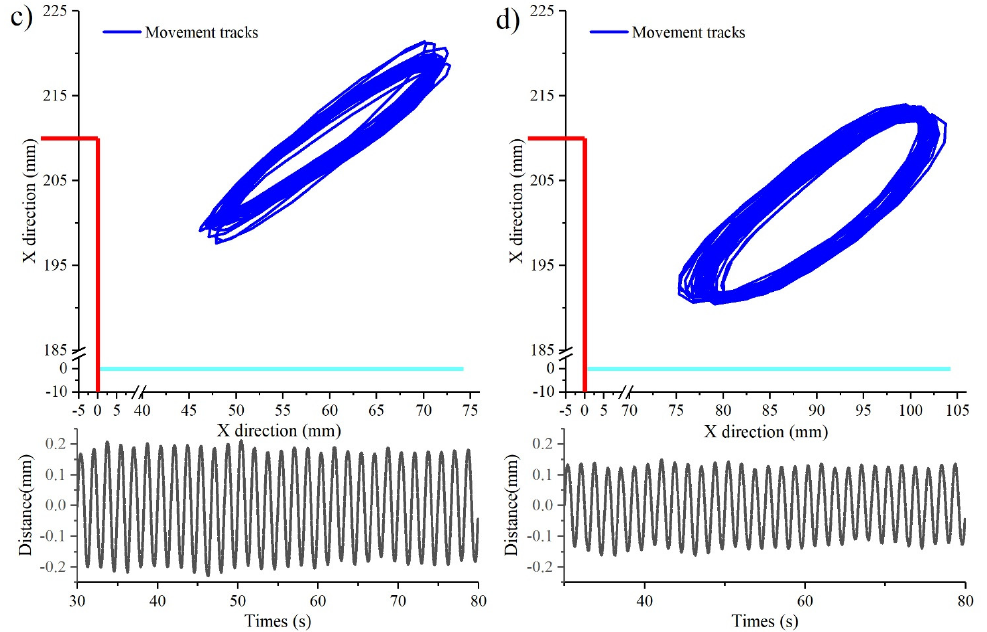
Figure 7. Movement tracks and distance between floating tank and dock of four different resonance conditions. ( a ) The coupled resonance of sloshing and the narrow gap in case 2-5; ( b ) the sloshing resonance in case 2-6; ( c ) the narrow gap resonance in case 2-1; ( d ) the non-resonance in case 2-2. The red and blue lines represent the position of the dock and the still water level surface, respectively.